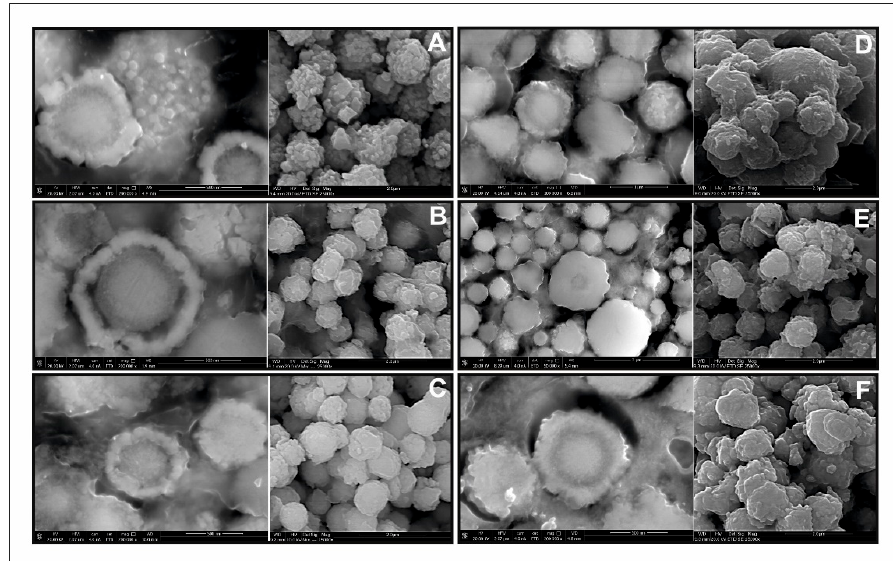
Figure 12. Scanning electron microscopy images of Cu 2 (Mn 1 − x Fe x )SnS 4 solid solution series: ( A ) Cu 2 FeSnS 4 (CFTS); ( B ) Mn 0.2 Fe 0.8 ; ( C ) Mn 0.4 Fe 0.6 ; ( D ) Mn 0.6 Fe 0.4 ; ( E ) Mn 0.8 Fe 0.2 ; ( F ) Cu 2 MnSnS 4 (CMTS). The left image in each pair is taken from polished samples immersed in epoxy resin to show the inner nanostructure of the microspheres on the cross-sections, the right one is from raw powders.